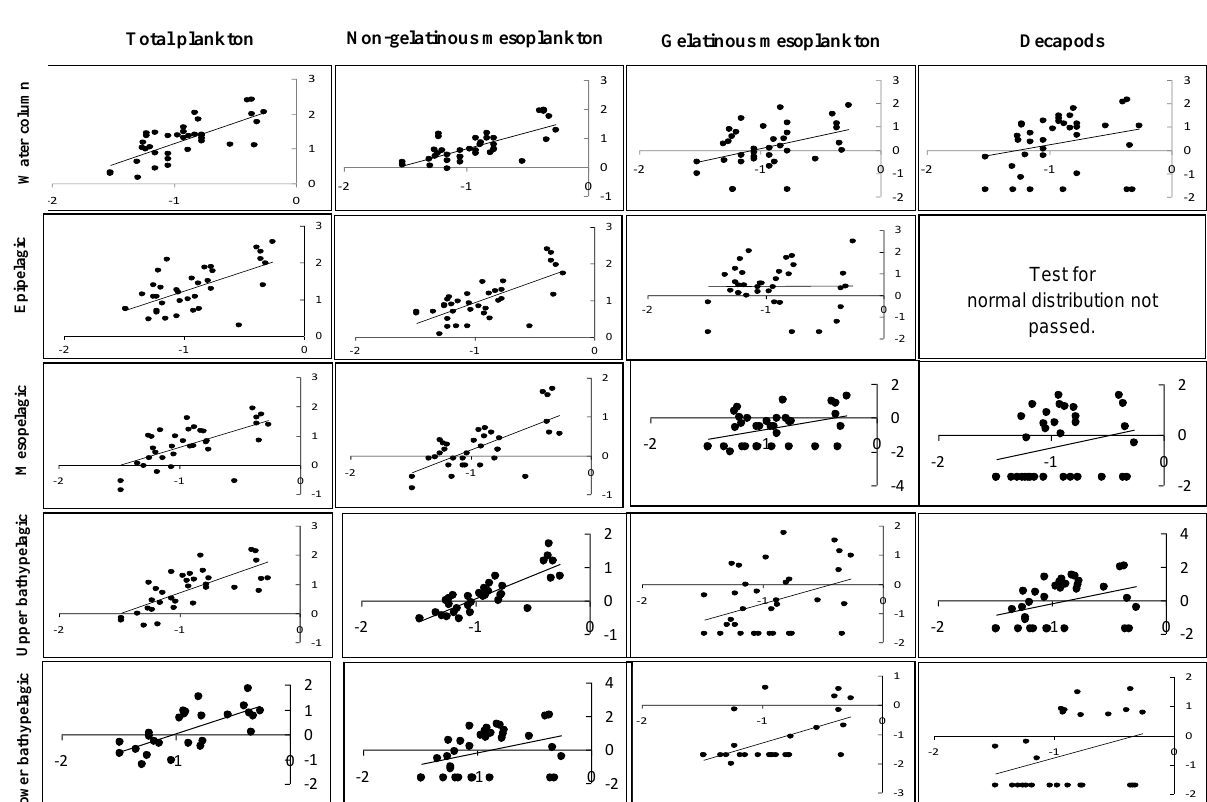
Figure 5. Wet biomass of major plankton groups (vertical axes) in the whole water column (gm − 2 ) and in different vertical zones (mgm − 3 ) versus surface chlorophyll (horizontal axes, mgm − 2 )